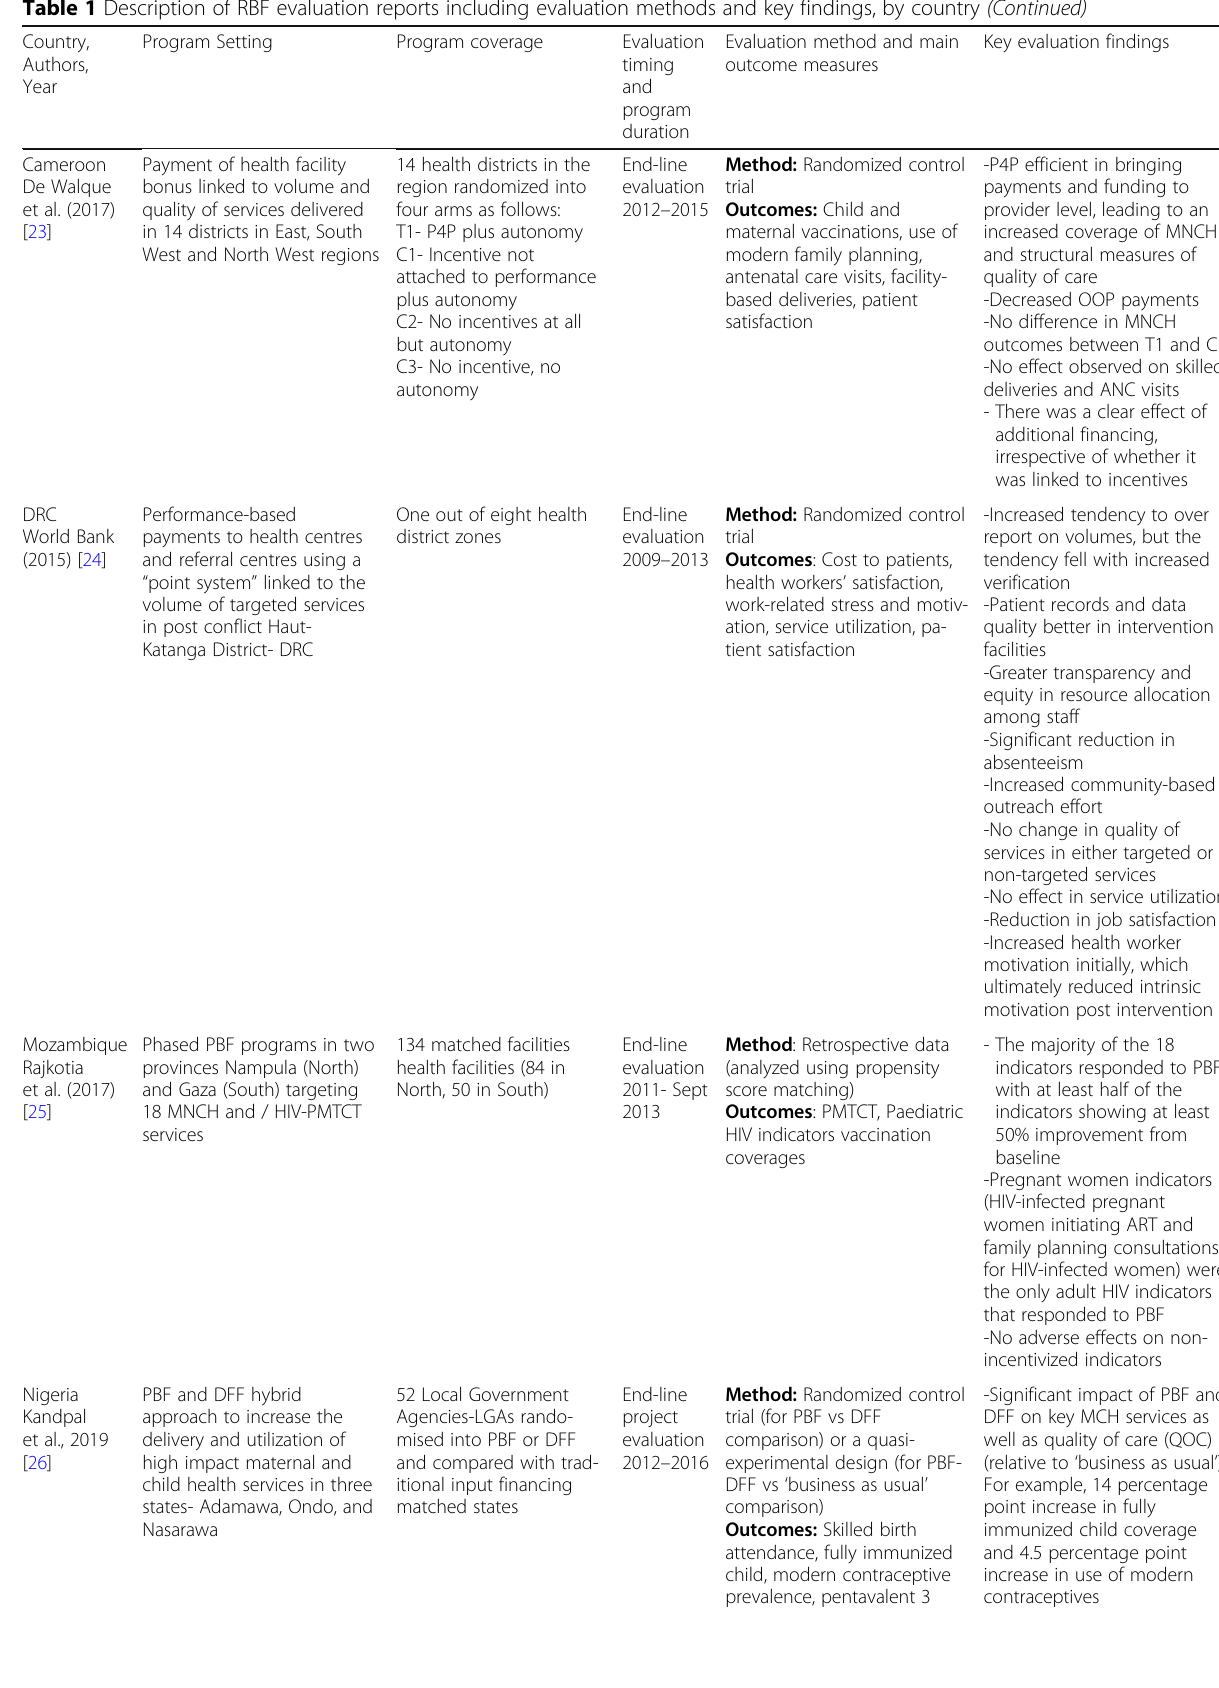
Table 1 Description of RBF evaluation reports including evaluation methods and key findings, by country